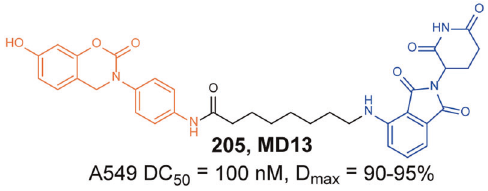
Fig. 62) based on a induce the degradation of endogenous PARP14 with DC 50 about